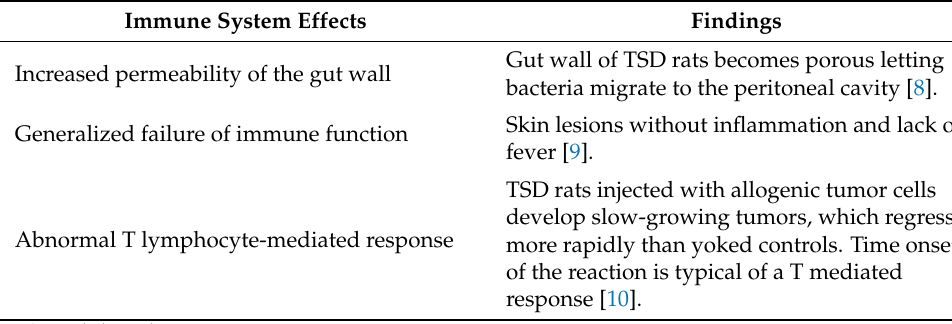
Table 2. Host defense effects in TSD